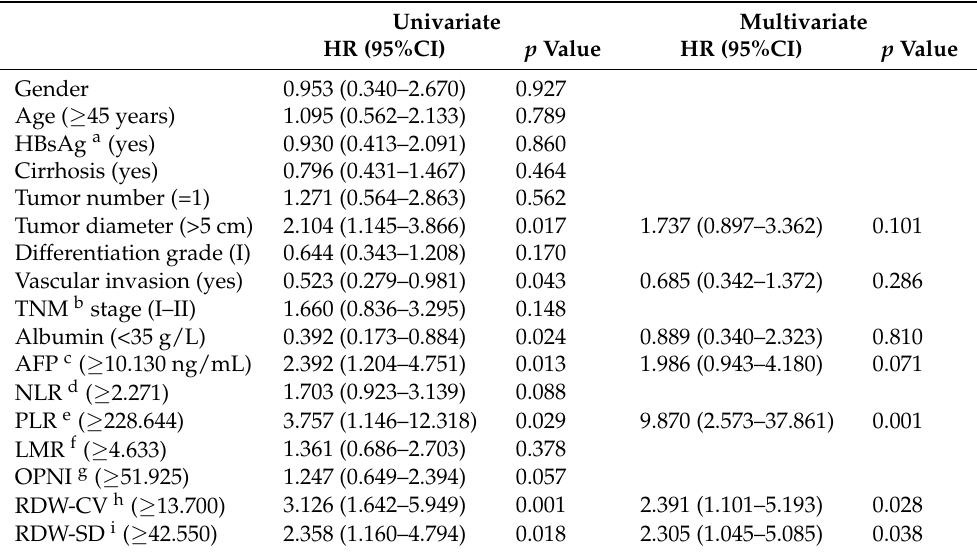
Table 2. Univariate and multivariate analyses of the prognostic factors of recurrence-free survival among HCC patients who received curative